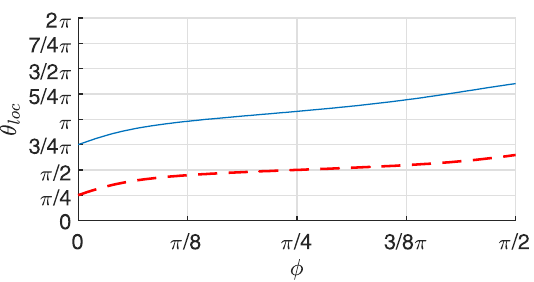
Figure 10. Dependence of θ compression